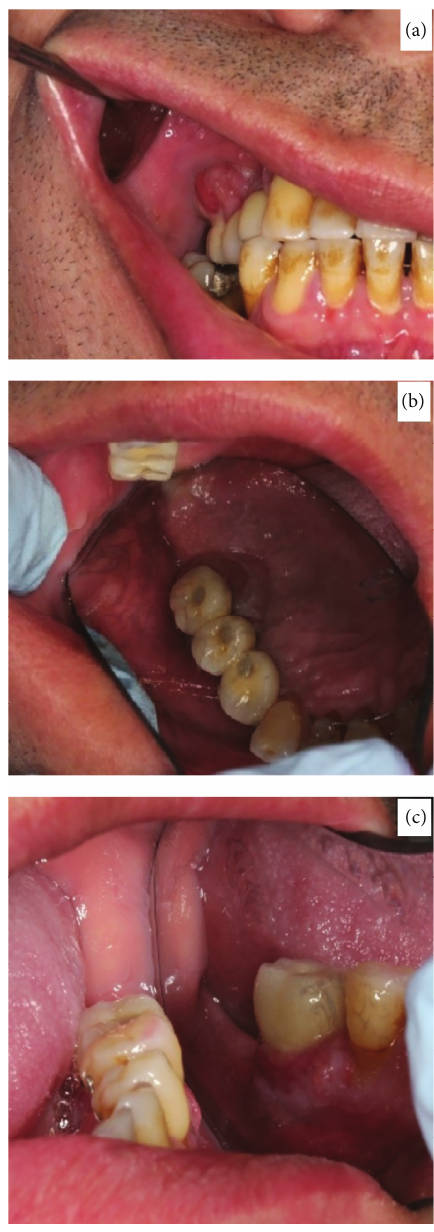
Figure 1: (a) Exophytic granulomatous lesion in 16 and 17 implants. (b) Palatal view of the granulomatous lesion in 16 and 17. (c) Granulo- matous lesion in